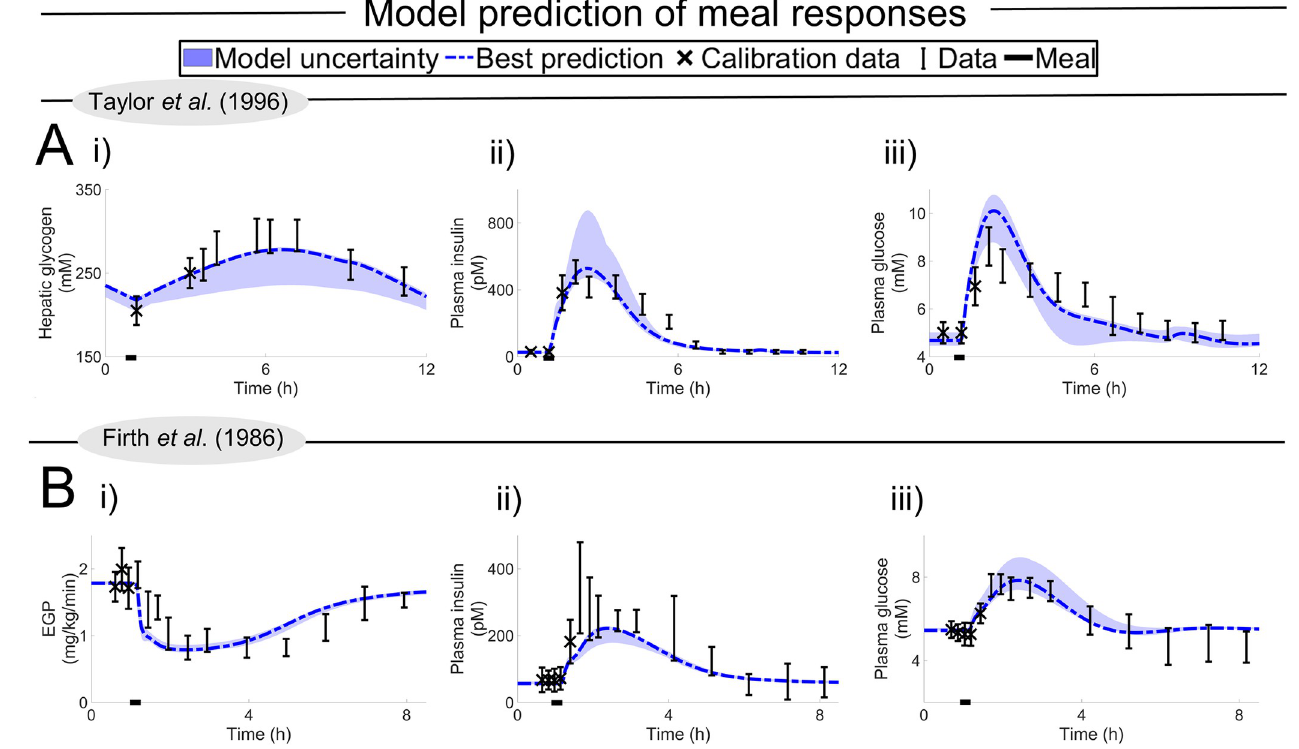
Fig 5. Second validation test with the model, using two clinical studies not used for training the model [30,31]. In all plots, data values are depicted with error bars (SEM), simulation uncertainties are depicted by the areas, and the simulation that best agrees with the data is depicted with the dash-dotted line. The first couple of data points (depicted with an X) are used for personalising the model, and the remaining data points are used for validation. (A) Prediction of mixed meal (black bar) from Taylor data [30], i) hepatic glycogen ii) plasma insulin iii) plasma glucose. (B) Prediction of OGTT (black bar) from Firth data [31], i) endogenous glucose production ii) plasma insulin iii) plasma